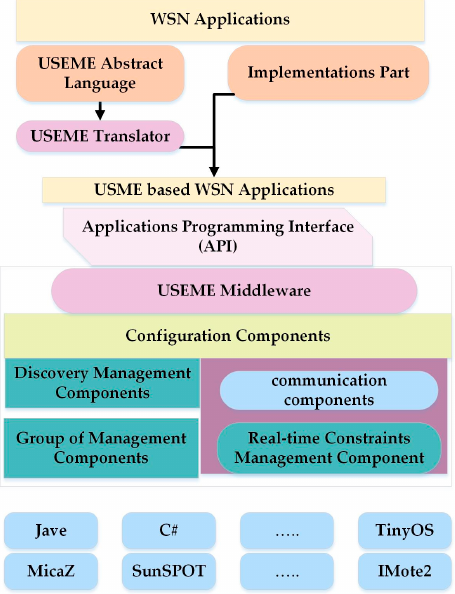
Figure 5. USEME Architecture [45].